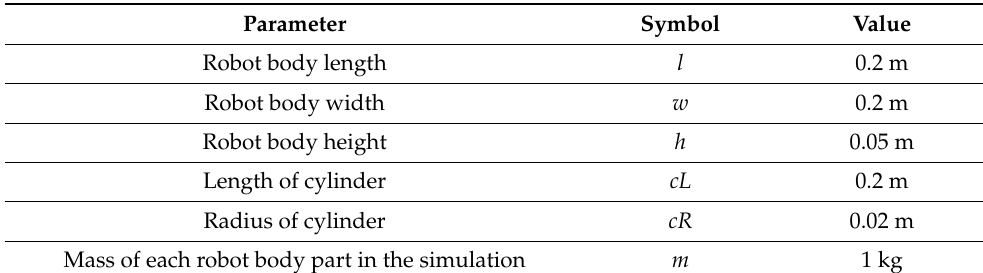
Table 1. Simulation parameters used in the simulator.